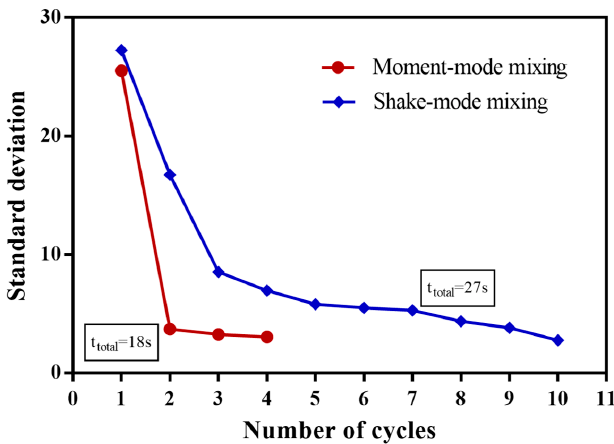
Figure 6. Demonstration of the variation of the histogram standard deviation value for the mixed liquid using shake-mode and moment of inertia mixing methods (the lower standard deviation value means higher mixing efficiency).